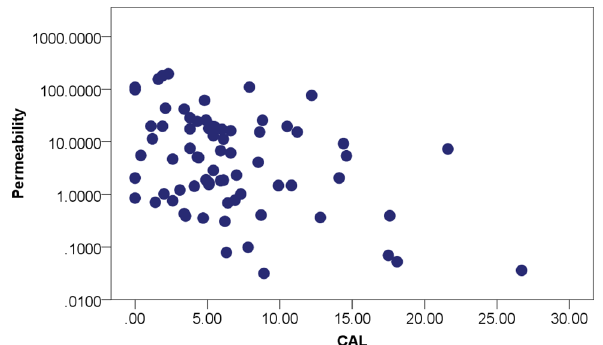
Fig. 9 Carbonate content and permeability crossplot